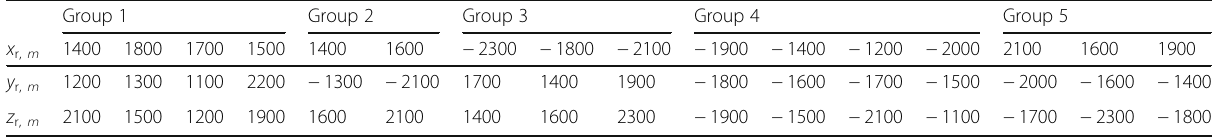
Table 4 Sensor positions in the unit of meters Group 1